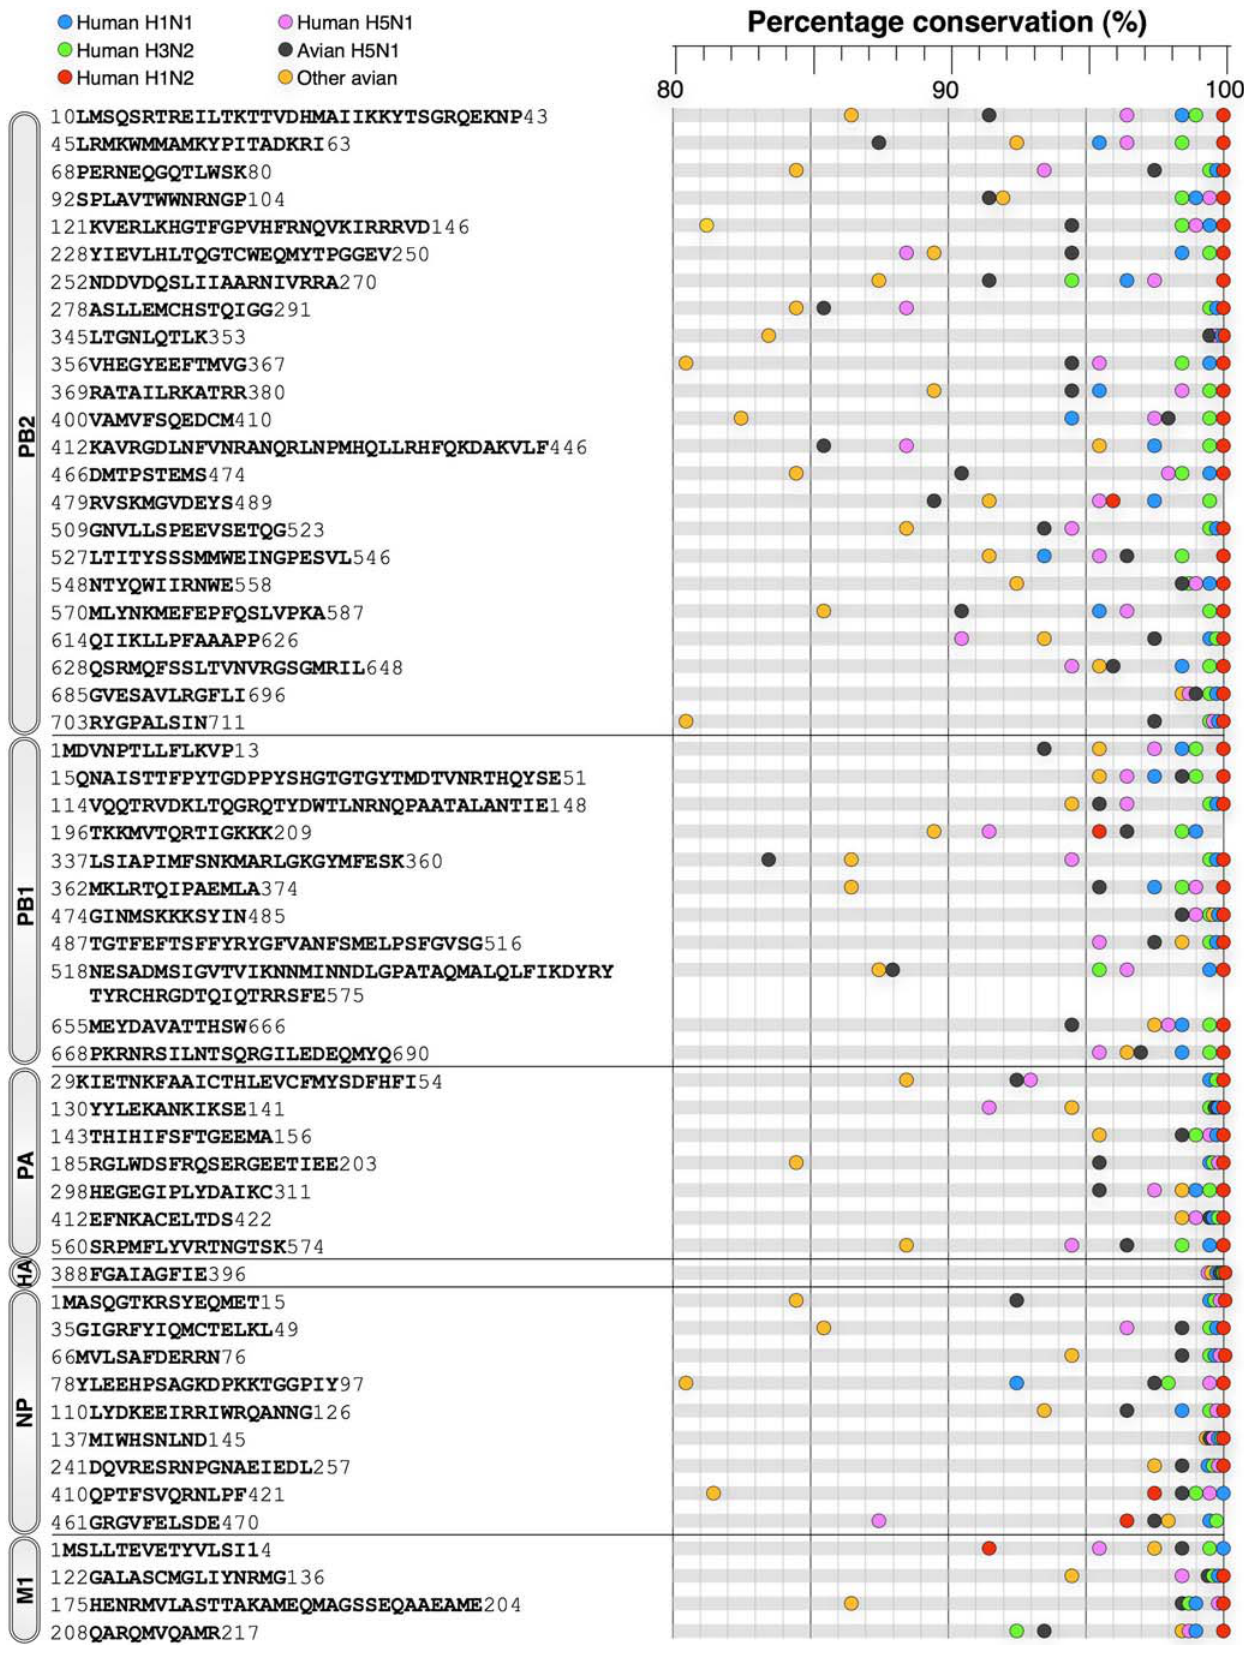
Figure 6. Highly conserved sequences of influenza A viruses in human H1N1, H3N2, H1N2, H5N1, avian H5N1, and other avian subtypes circulating between1997and2006. Aregionintheviralproteomeisconsideredashighlyconservedwhenithasidenticalsequenceconservationofatleast9contiguous amino acids in 80% or more of the protein sequences of the analyzed dataset. The index of virus colored symbol is as shown at the top of the figure. doi:10.1371/journal.pone.0001190.g006 PLoS ONE |